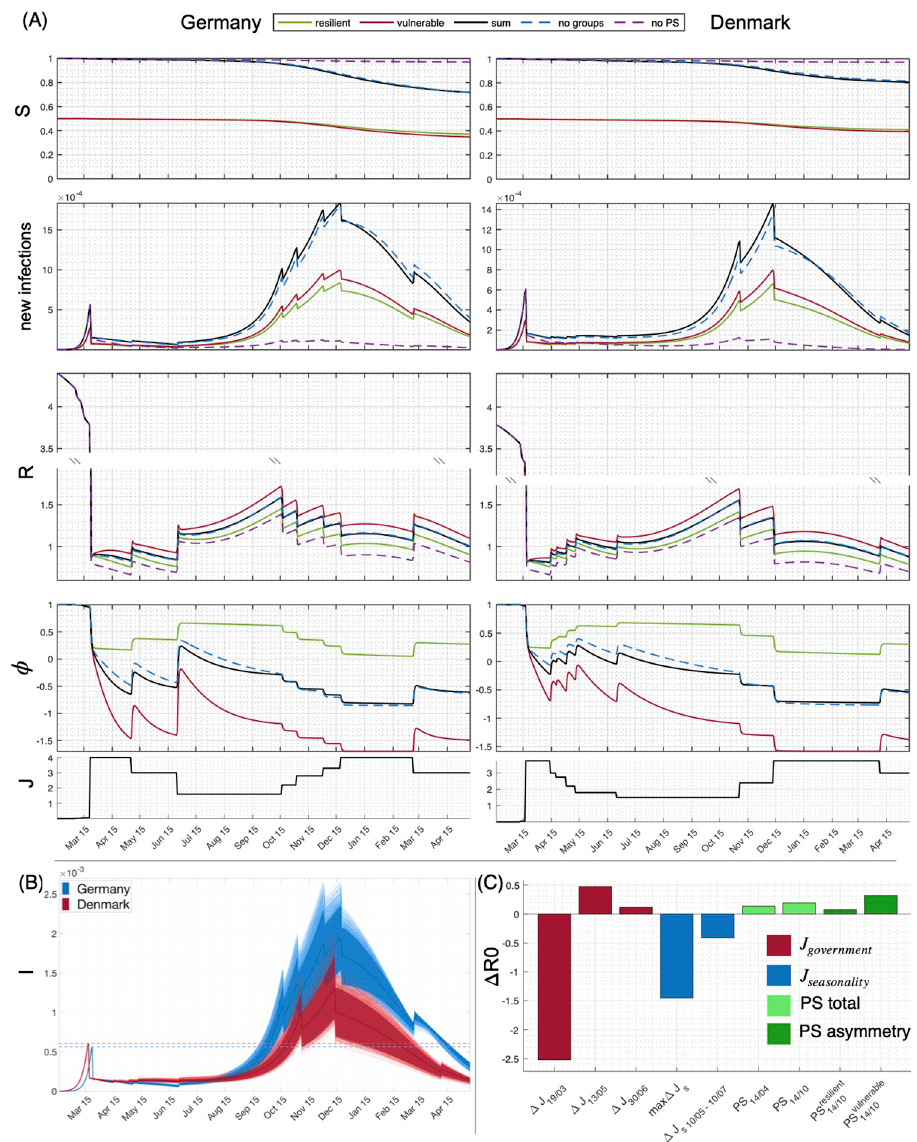
Fig 4. Forecast of the evolution of COVID 19 spread for Germany and Denmark. (A) Simulations of the SIR (dashed magenta), PS-SIR model with (black) and without group structure (dashed blue) for Germany (left) and Denmark (right) as well as the PS-SIR model split up for populations assuming 50% vulnerable (red) or resilient (green) citizens, simulated until May 2021. “S” denotes the ratio of susceptible, new infections are derived from “ I” , “R” is the reproduction factor, phi perceived negative AFFECT, and J political interventions. The default parameters in all the plots are from a run of the chain that best fits the data shown in Fig 2 up to mid-May 2020. Simulations contain all the government interventions up to the spring of 2021. (B) Ensemble projection of infections for all the combinations of inferred parameters for both countries (light red and blue lines), the mean (red and blue line) and the areas of 95% confidence (shaded red and blue). (C) Estimated strengths of interventions on infectious spread for Denmark (results for Germany are comparable and provided in the Supplementary Information, S2 Fig): Red is the impact of the government interventions (the largest on 19/03, and the subsequent relaxations on 13/05 and 30/06); blue is seasonality (the maximum impact, and the impact for 2 months after the relaxation on 10/05 to 10/07). Green is the impact of the PS subsystem, where light green is the cumulative impact before the relaxation on 14/04 and before the predicted intervention in autumn; and dark green is the predicted impact in autumn 2020, separated per group.